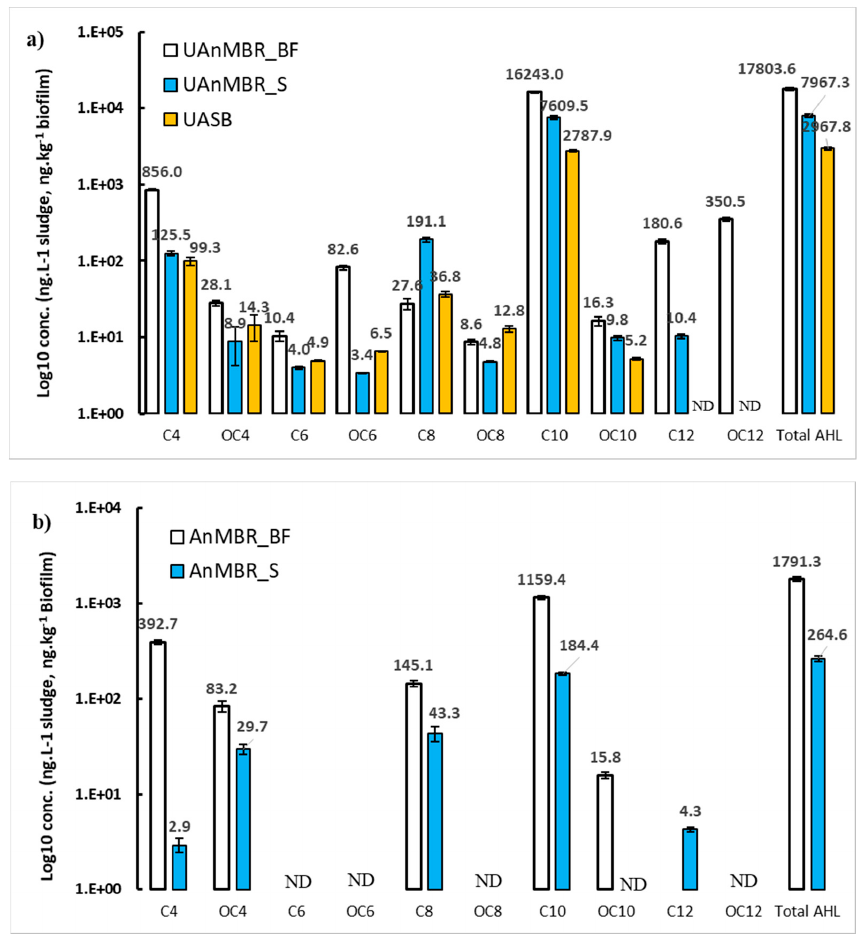
Figure 2. Acyl homoserine lactone (AHL) concentrations in the biofilm (ng kg − 1 ) and sludge (mg L − 1 ) of ( a ) UAnMBR and UASB (sludge only), ( b ) AnMBR (error bars show standard deviation of replicates; n = 2); the y ‐ axis is a log scale. AHL abbreviations are; C4: C4 ‐ HSL; C6: C6 ‐ HSL; C8: C8 ‐ HSL; C10: C10 ‐ HSL; C12: C12 ‐ HSL; OC4: 3 ‐ oxo ‐ C4 ‐ HSL; OC6: 3 ‐ oxo ‐ C6 ‐ HSL; OC8: 3 ‐ oxo ‐ C8 ‐ HSL; OC10: 3 ‐ oxo ‐ C10 ‐ HSL; OC12: 3 ‐ oxo ‐ C12 ‐ HSL. The abbreviation of ND; not detected.